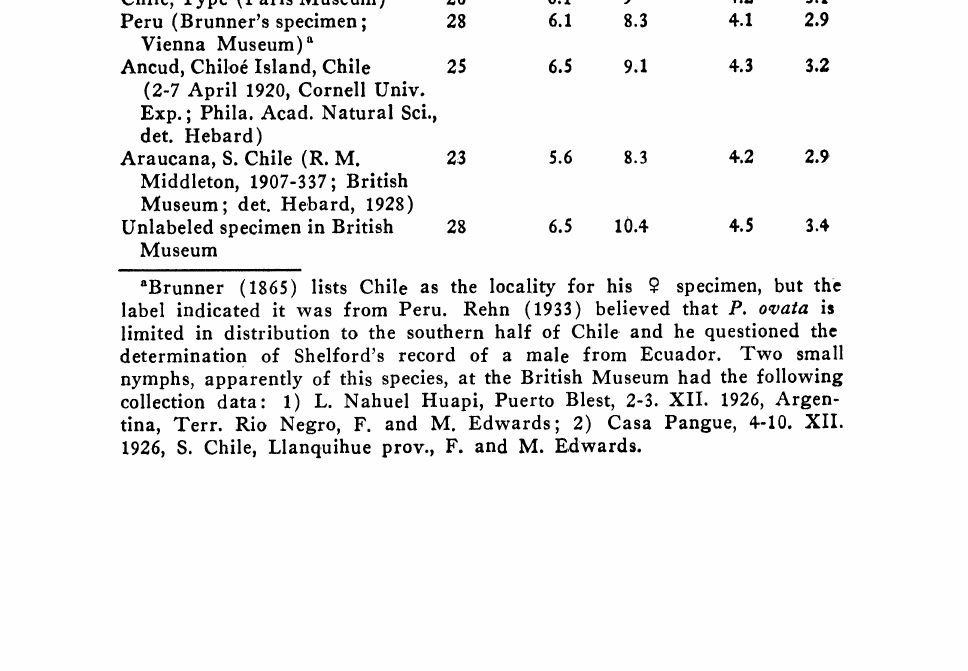
TABLE 1. Measurements (mm) of Paraskhaeria ovata Ov era 11 Pr onotum Tegme n body